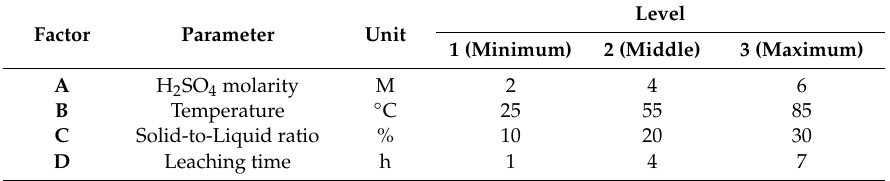
Table 1. Parameters and their values at each level to be set and studied in